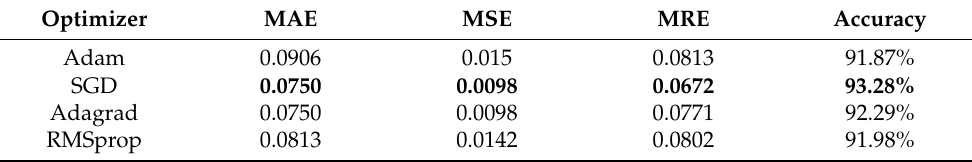
Figure 10. The effects of optimizer on the prediction loss of the proposed model at A 1 . (MSE and MAE are in units of 0.1xTECU). Table 3. Effects of optimizer on the prediction loss of the proposed model at A 1 .